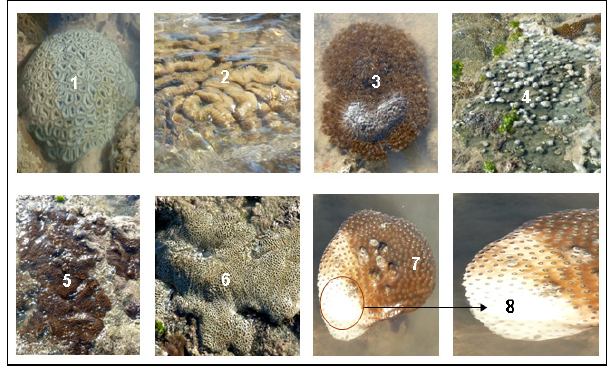
Figure 4. Field photographs of the eight coral targets